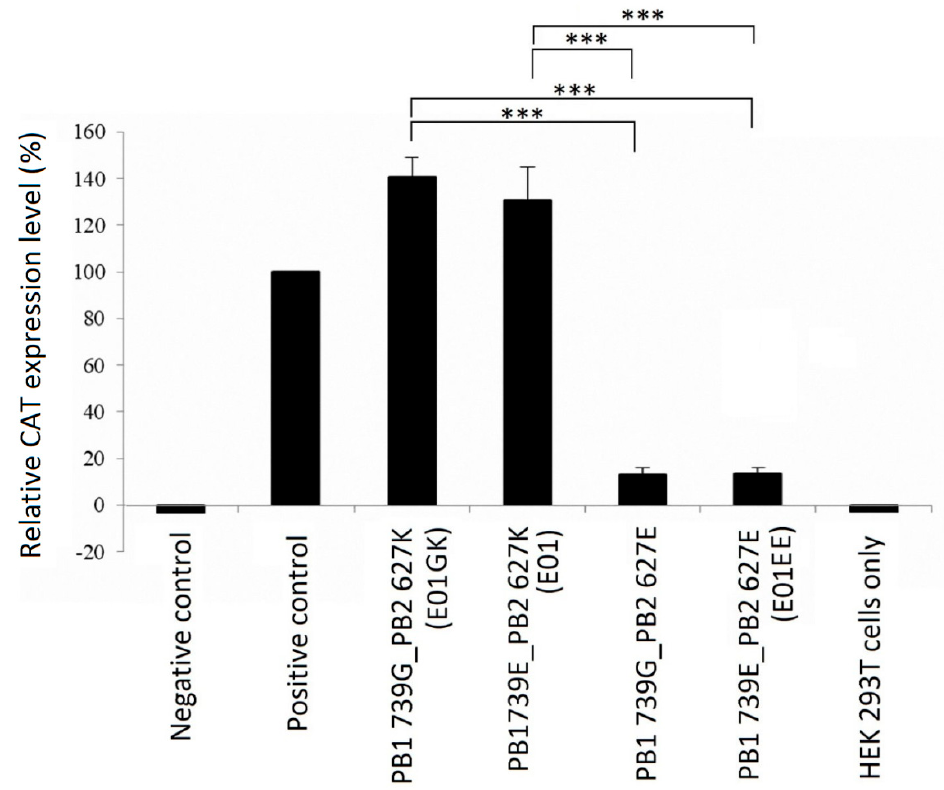
Figure 4. The viral ribonucleoprotein (RNP) activity was signaled using CAT ELISA and displayed as relative CAT expression level. All RNP complex varieties exhibited di ff erent combinations of PB1 and PB2 residues were tested. Negative control: plasmid pcDNA3.1 only; Positive control: plasmid pcDNA3.1 / CAT. No significant di ff erences were noted between E01GK and E01. There were also no significant di ff erences among groups of negative control, PB1739G_PB2 627E, E01EE and HEK 293T cells. ***: p < 0.001.